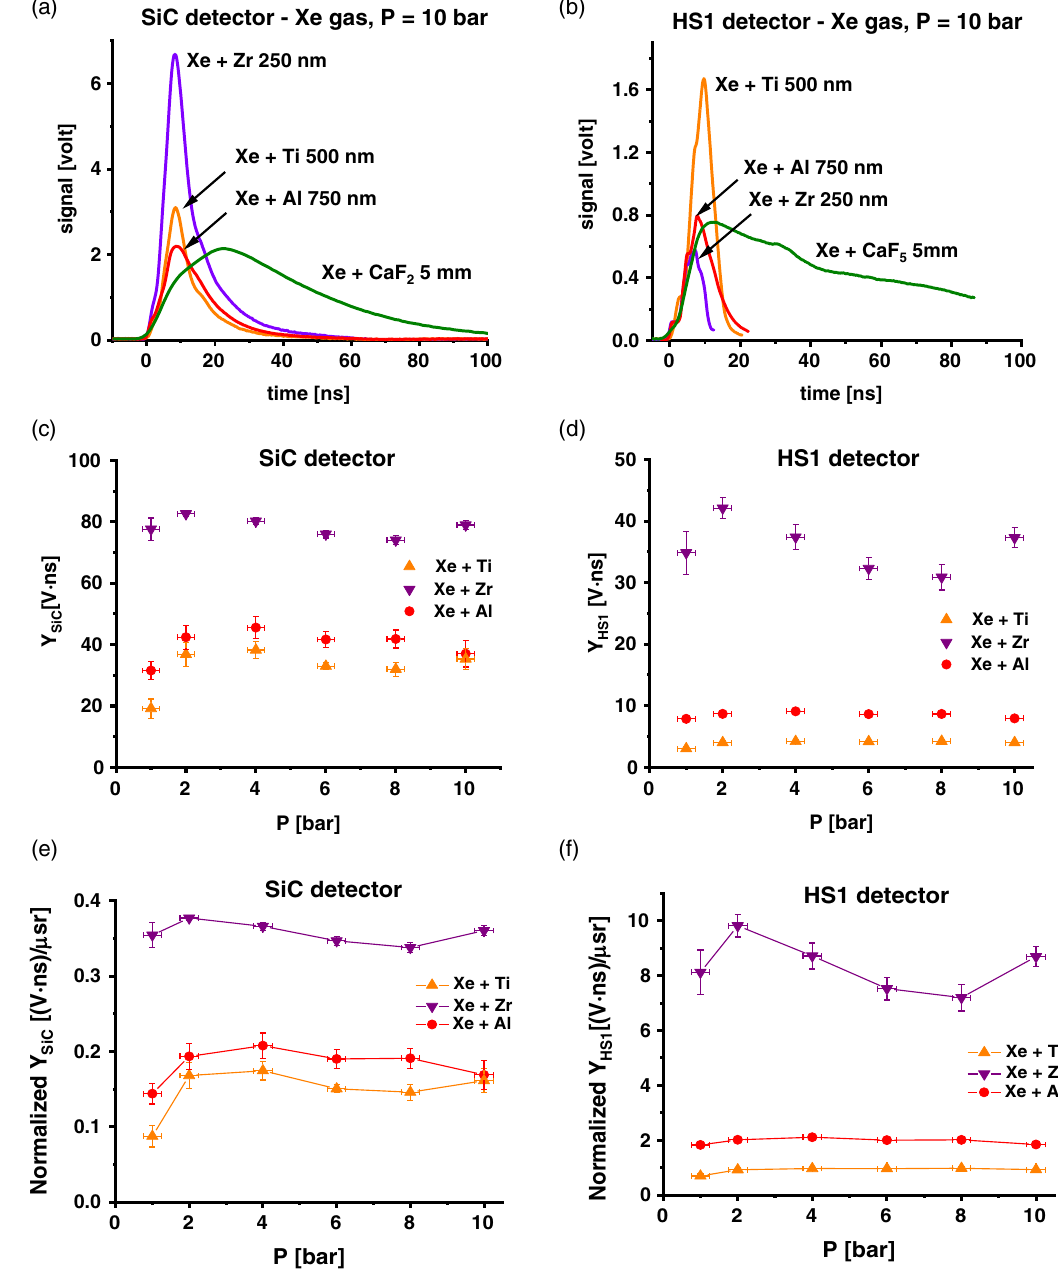
FIG. 3. Time traces of the detector signals for Xe plasma emission with HS1 (a) and SiC (b) for different wavelength ranges (from SXR to UV) selected by various filters. (c) and (d) show the integrated signal of HS1 and SiC as a function of the applied gas-puff backing pressures of Xe gas at a constant He pressure of 6 bar, while (e) and (f) show the integrated signal normalized in terms of a solid angle ( 219 μ sr for SiC and 4.29 for